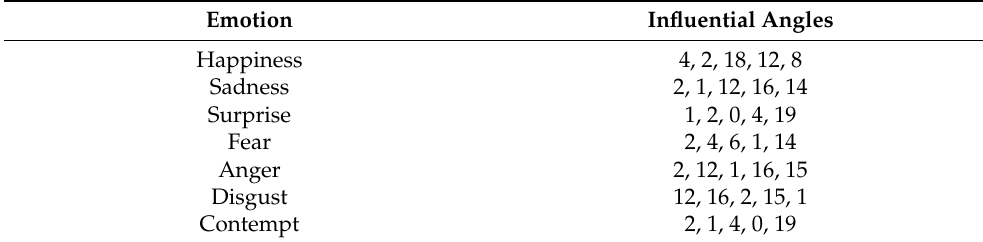
Table 8. List of the 5 most influential angles for each